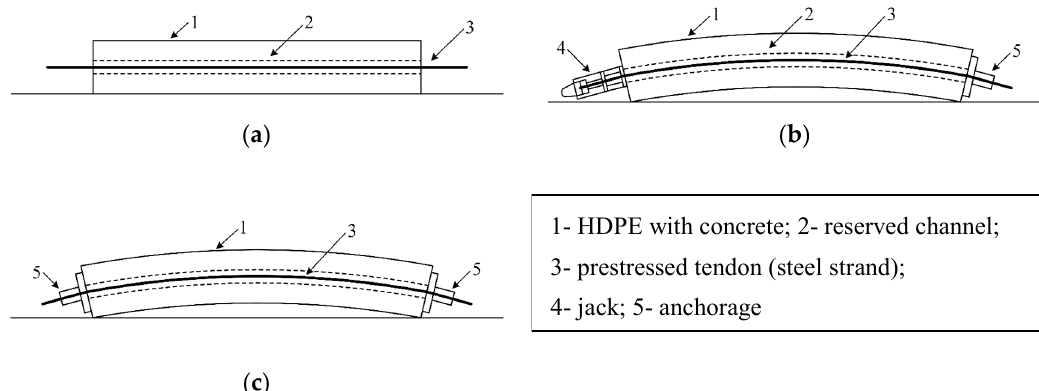
Figure 1. Method of production for external post-tensioned pre-stressed concrete. ( a ) Modeling concrete component; ( b ) pulling steel bar; ( c ) anchoring and grouting.